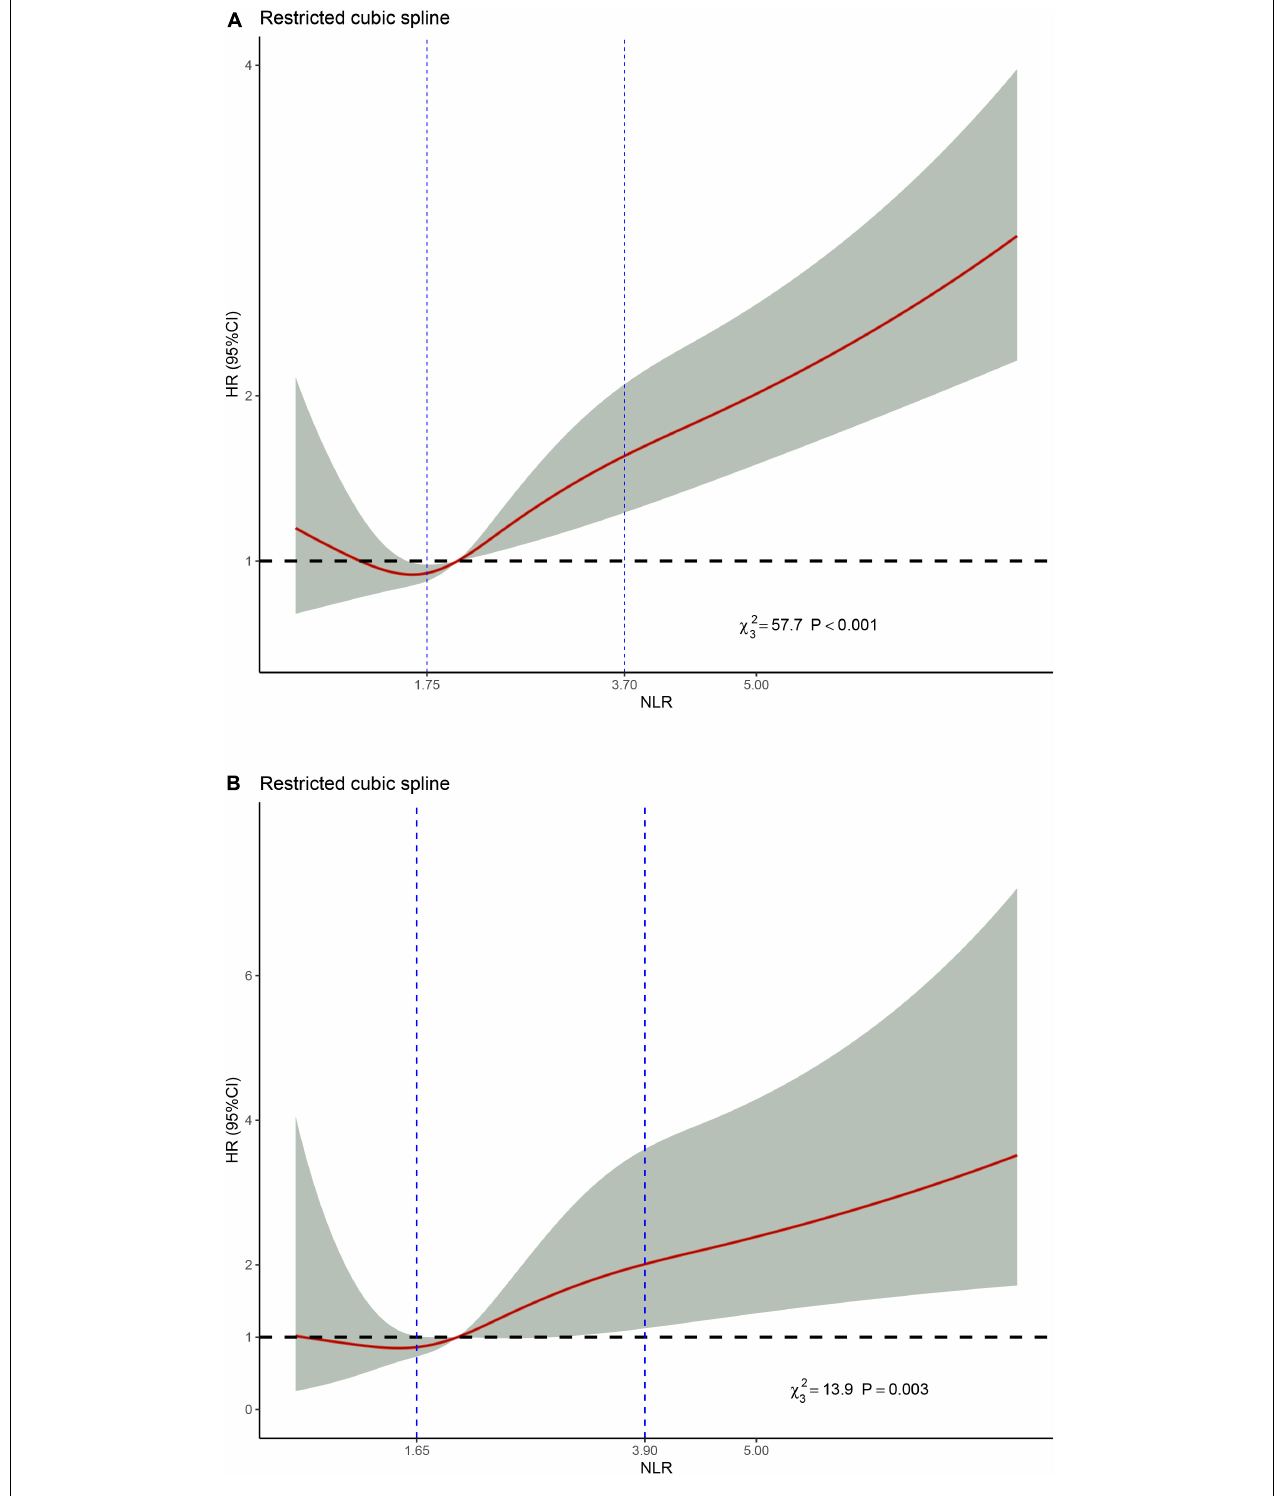
FIGURE 5 | (A) Non-linear relationship between NLR and all-cause mortality. Adjusted for age, gender, race, smoking, condition, glucose, BMI, and albumin. (B) Non-linear relationship between NLR and cardiovascular mortality. Adjusted for age, gender, cancer, hypertension, condition, diabetes, BMI, glycated hemoglobin, and